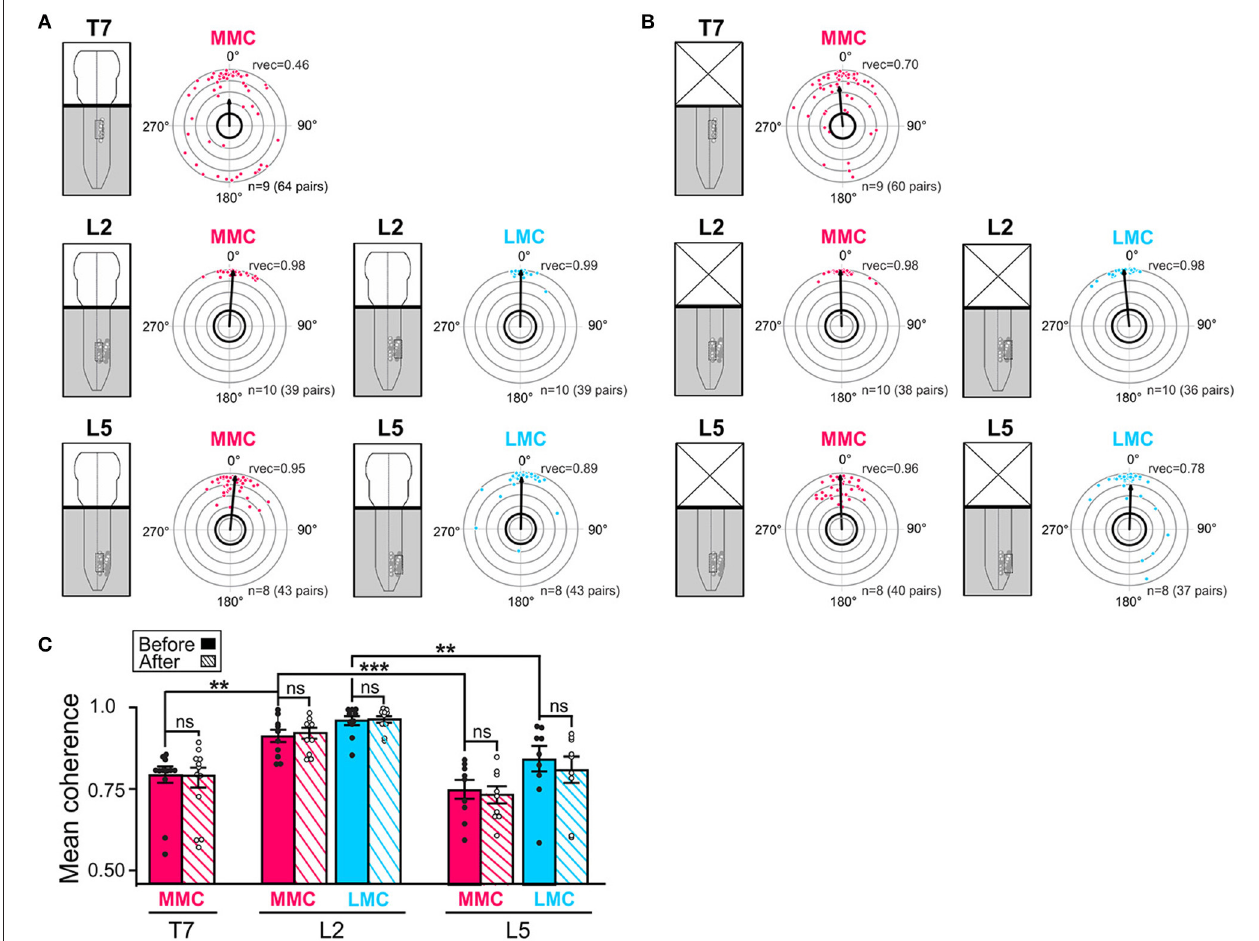
FIGURE 4 | Temporal relationships and coupling strengths (coherence) between MNs of the same motor column before and after removal of the brain stem. (A,B) Intra-columnar phase relationships between pairs of MNs in T7 MMC (top), L2 MMC and LMC (middle) and L5 MMC and LMC (bottom) before and after removal of the brain stem, respectively. Phase relationships between MN pairs are shown as phase differences in circular plots. Individual dots represent individual MN pairs (red = > MMC, blue = > LMC). The direction of the vectors (arrows) indicates mean phase difference (0 ◦ = > synchronous, 180 ◦ difference = > alternating) whereas the length of the vectors (rvec) indicates the extent to which the phase differences are clustered around the mean on a scale from 0.0 (origin) to 1.0 (outermost gray circle). The circle with thick black outline indicates the p < 0.05 level of statistical significance as determined by the Rayleigh test. Number of experiments and number MN pairs analyzed indicated at the bottom of each circular plots. The lower average vector length “rvec” in T7 indicates a more widespread distribution of phase differences between MNs in this segment than in L2 or L5. Phase differences were clustered in two groups around 0 and 180 ◦ . The changes in mean phase vectors after removal of the brainstem were not statistically significantly (Watson–Williams F -test, T7 MMC before vs. MMC after F = 0.83, p = 0.38; L2 MMC before vs. MMC after F = 2.25, p = 0.15; L2 LMC before vs. LMC after F = 2.53, p = 0.13; L5 MMC before vs. MMC after F = 1.28, p = 0.28; L5 LMC before vs. LMC after F = 1.28, p = 0.63). (C) Bar graph showing the mean coherence before (solid bars) and after (hatched bars) removal of the brain stem. The coupling between MNs was significantly tighter in L2 than in T7 or L5 both before and after removal of the brain stem (Kruskal-Wallis test followed by a Dunn’s multiple comparison, L2 MMC before vs. T7 MMC before p = 0.007; L2 MMC before vs. L5 MMC before p = 0.0004; L2 LMC before vs. L5 LMC before p = 0.001; L5 MMC before vs. T7 MMC before p > 0.99; Wilcoxon matched paired test, T7 MMC before vs. MMC after p = 0.82; L2 MMC before vs. MMC after p = 0.56; L2 LMC before vs. LMC after p > 0.99; L5 MMC before vs. MMC after p = 0.73; L5 LMC before vs. LMC after p = 0.57). ** p < 0.01, *** p <